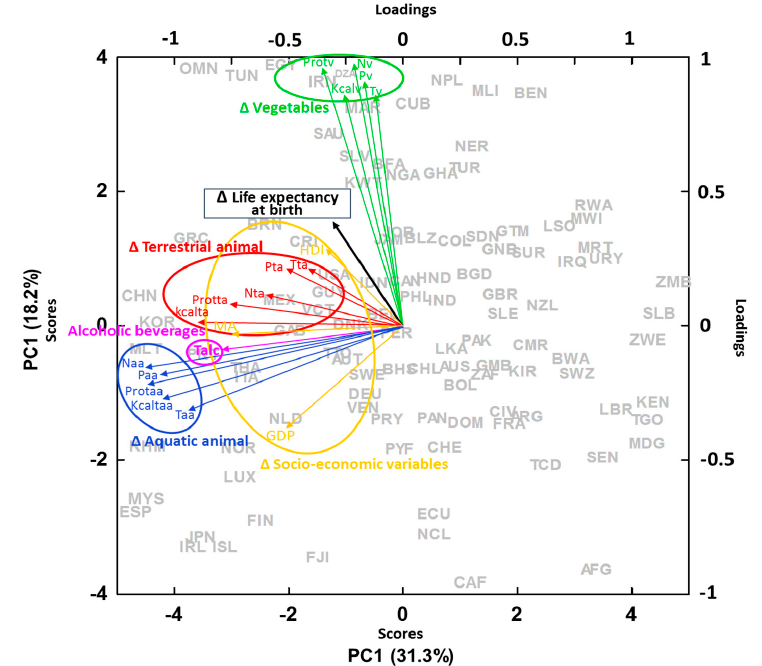
Figure 6. PCA with the increases of mean averages during the period 1960–2010 of country life expectance at birth (LE), different socioeconomic variables (AM = age mean, HDI = human development index, GDP = gross domestic product per capita) and food sources (t = total, N = nitrogen intake, P = phosphorus intake, prot = protein and Kcal = kilocalories per capita intake) from terrestrial animal sources (ta) (red), vegetables (v) (green), and aquatic animal (aa) (blue). AFG = Afghanistan, DZA = Algeria, ARG = Argentina, AUS = Australia, AUT = Austria, BHS = Bahamas, BGD = Bangladesh, BEL = Belgium, BLZ = Belize, BEN = Benin, BOL = Bolivia, BWA = Botswana, BRN = Brunei Darussalam, BFA = Burkina Faso, KHM = Cambodia, CMR = Cameroon, CAN = Canada, CAF = Central African Republic, TCD = Chad, CHL = Chile, CHN = China, COL = Colombia, CRI = Costa Rica, CIV = Cote Ivoire, CUB = Cuba, DNK = Denmark, DOM = Dominican Republic, ECU = Ecuador, EGY = Egypt, SLV = El Salvador, FJI = Fiji, FIN = Finland, FRA = France, PYF = French Polynesia, GAB = Gabon, GMB = Gambia, DEU = Germany, GHA = Ghana, GRC = Greece, GTM = Guatemala, GNB = Guinea-Bissau, GUY = Guyana, HND = Honduras, ISL = Iceland, IND = India, IDN = Indonesia, IRN = Iran, IRQ = Iraq, IRL = Ireland, ITA = Italy, JAM = Jamaica, JPN = Japan, JOR = Jordan, KEN = Kenya, KIR = Kiribati, KOR = Korea, KWT = Kuwait, LSO = Lesotho, LBR = Liberia, LUX = Luxembourg, MDG = Madagascar, MWI = Malawi, MYS = Malaysia, MLI = Mali, MLT = Malta, MRT = Mauritania, MEX = Mexico, MAR = Morocco, NPL = Nepal, NLD = Netherlands, NCL = New Caledonia, NZL = New Zealand, NER = Niger, NGA = Nigeria, NOR = Norway, OMN = Oman, PAK = Pakistan, PAN = Panama, PRY = Paraguay, PER = Peru, PHL = Philippines, PRT = Portugal, RWA = Rwanda, VCT = Saint Vincent and the Grenadines, SAU = Saudi Arabia, SEN = Senegal, SLE = Sierra Leone, SLB = Solomon Islands, ZAF = South Africa, ESP = Spain, LKA = Sri Lanka, SDN = Sudan, SUR = Suriname, SWZ = Swaziland, SWE = Sweden, CHE = Switzerland, THA = Thailand, TGO = Togo, TTO = Trinidad and Tobago, TUN = Tunisia, TUR = Turkey, UGA = Uganda, GBR = United Kingdom, USA = United States of America, URY = Uruguay, VEN = Venezuela (Bolivarian Republic of), ZMB = Zambia, ZWE =